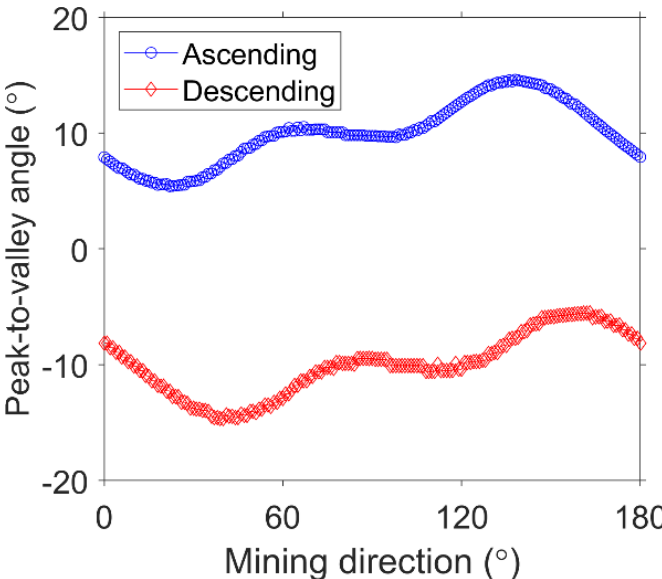
Figure 7. Peak-to-valley angles of the NOV-estimated subsidence errors with respect to the changes of underground mining directions from 0° to 180° for the LEO ascending and descending imaging views, respectively.